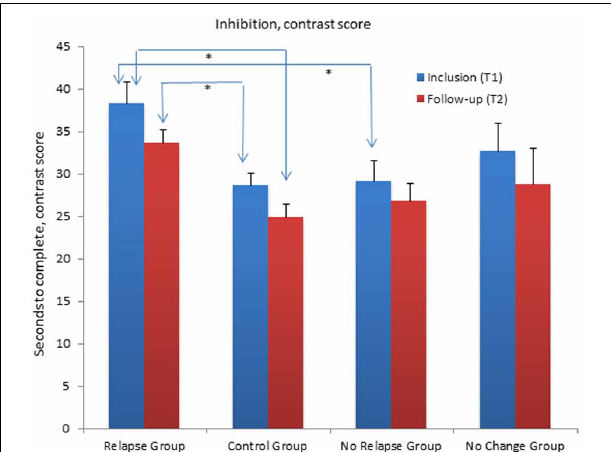
FIGURE 4 | Mean contrast scores for the Inhibition/switching condition of the Color Word Interference Test (CWIT) for the relapse group, the no relapse group, the no change group and the control group at inclusion (T1) and at follow-up assessment (T2). The Relapse Group performed significantly poorer compared ( p < 0 . 01) to the No Relapse Group and the Control Group at T1. At T2 the Relapse group performed significantly poorer than the Control Group ( p < 0 . 01). Graphs represent mean Standard Error (SE).